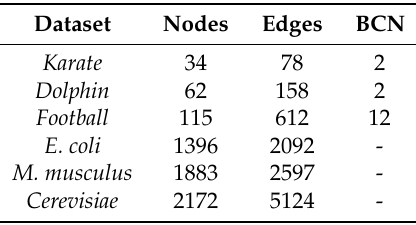
Table 1. Six real